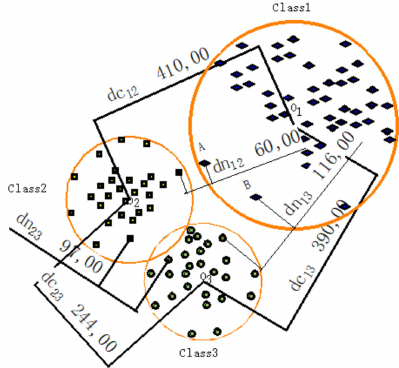
Figure 4. Two-dimensional spatial distribution of the three types of sample